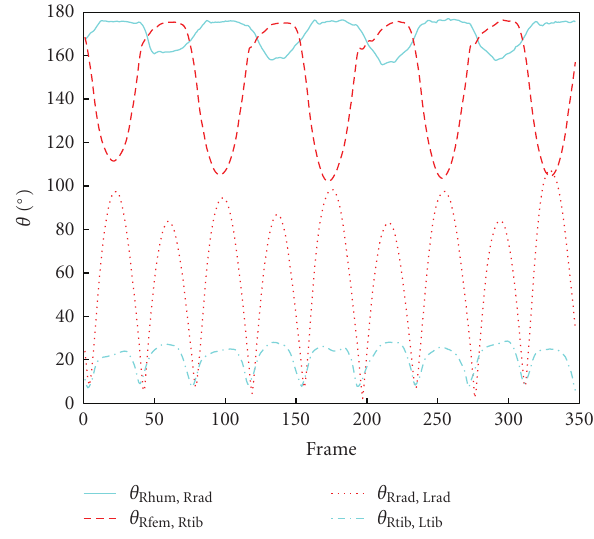
Figure 1: An example of the time series f for a walking subject.